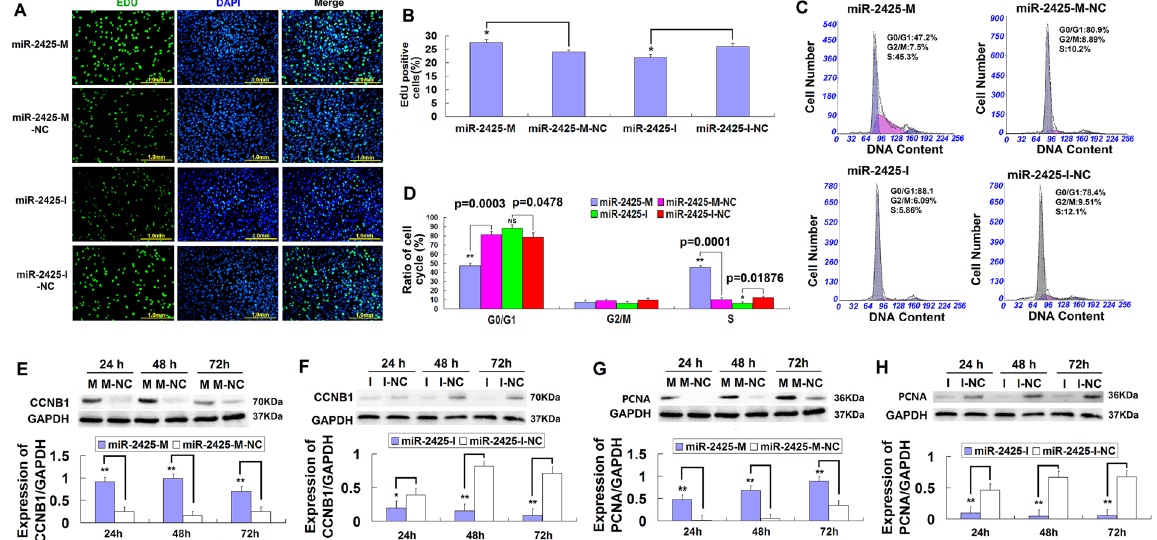
Figure 2. MiR-2425-5p promotes bovine MDSCs proliferation. ( A ) MDSCs were labeled with EdU. EdU- positive cells, green; cell nuclei, blue; magnification, 200 × . ( B ) Percentage of EdU-positive cells, n = 6. ( C ) Cycle analysis in cells treated with miR-2425-M, miR-2425-M-NC, miR-2425-I, or miR-2425-I-NC for 48 h. ( D ) Quantification of results shown in ( C ). Data represent the mean ± SEM (n = 3). (E, F) CCNB1 expression in MDSCs treated with ( E ) miR-2425-M or ( F ) miR-2425-I vs. controls at 24 h, 48 h, and 72 h. ( G , H ) PCNA expression in MDSCs after treatment vs. controls at 24 h, 48 h, and 72 h. * P < 0.05, ** P < 0.01, NS: no significant difference.